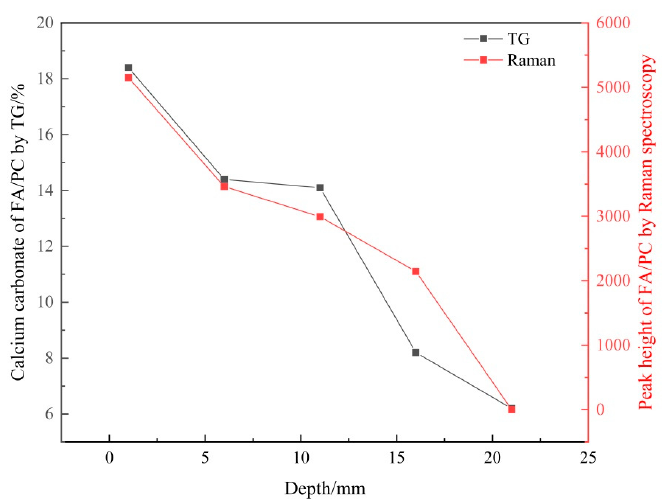
Figure 9. Carbonation profiles of the carbonated FA/PC paste samples established by Raman spectroscopy and TG analyses.